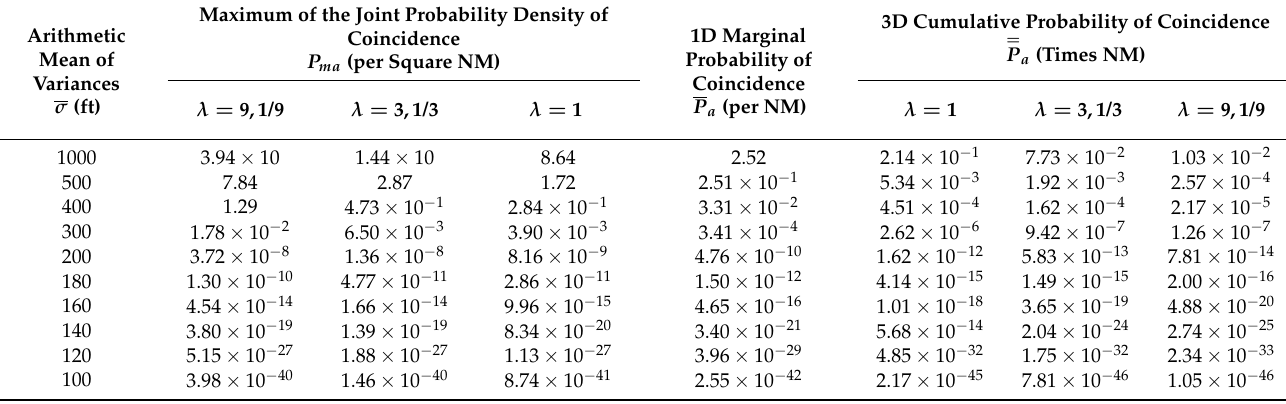
Table 2. Upper bound to probabilities of collision assuming Gaussian probability distribution with vertical separation L a = 2000 ft. Three values of the dissimilarity parameter in (40) are used in the maximum P m and of the 3D cumulative probability of coincidence, which was calculated for a vertical separation L = 2000 ft, for several values of the r.m.s. position error σ , which is calculated from (30a) as the arithmetic mean of the variances of the position errors of the two aircraft. The latter alone specifies the 2D marginal probability of coincidence across the flight path P , which can be compared directly with the original ICAO TLS standard and is independent of the aircraft dissimilarity